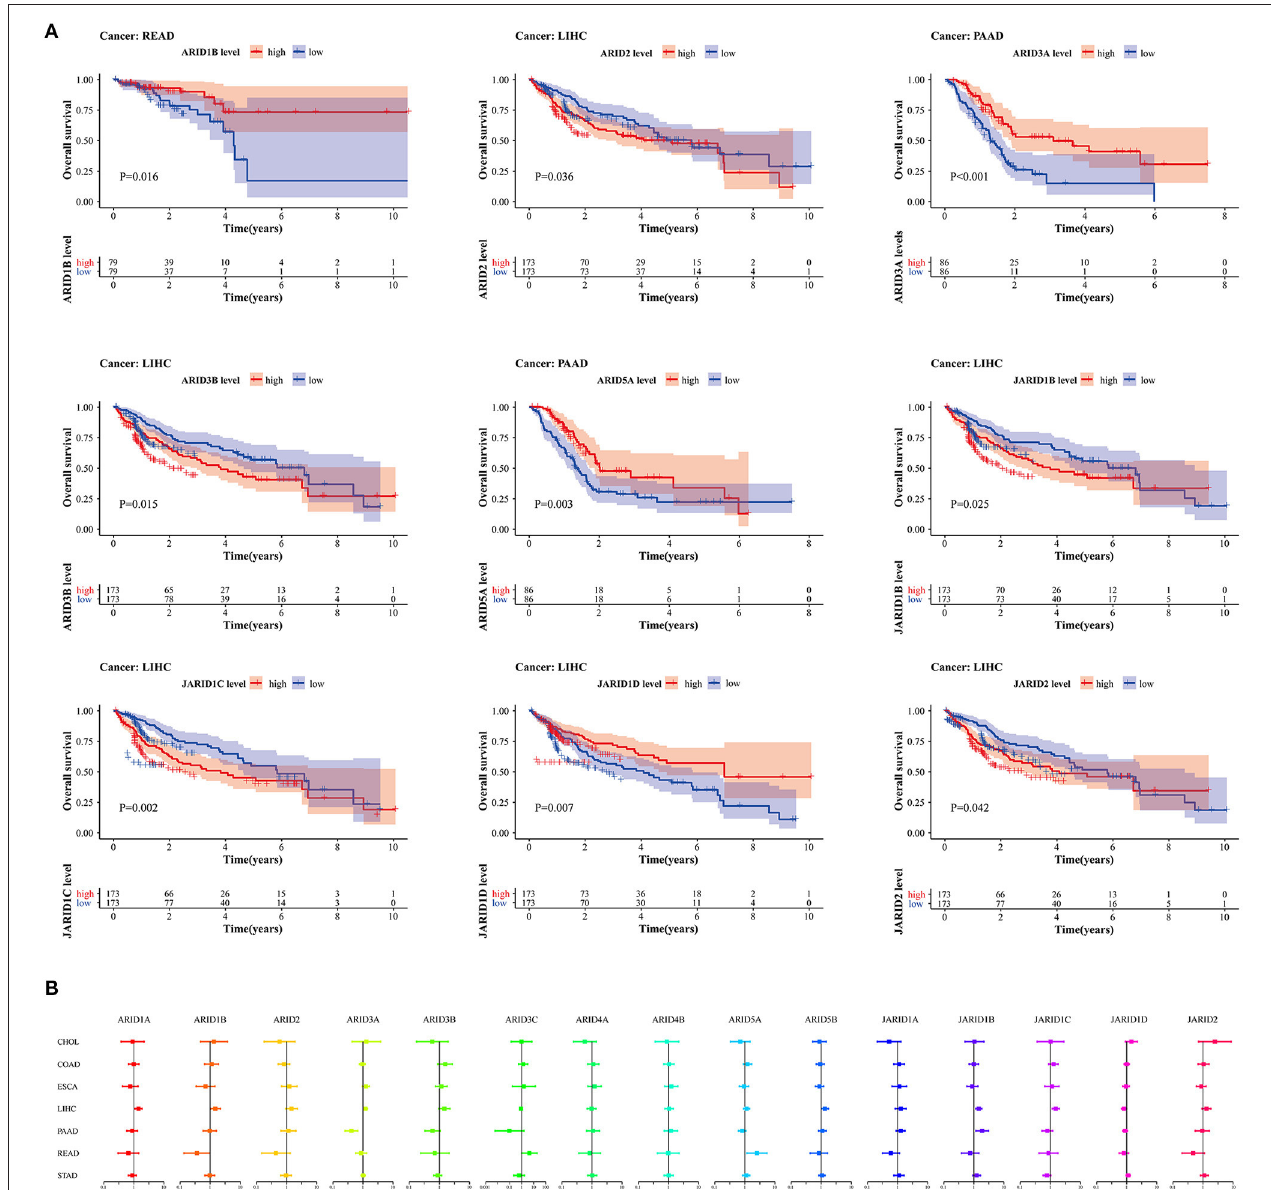
FIGURE 2 | Prognostic significance for ARID family members in digestive cancer. (A) Survival curves with statistical significance for 15 ARIDs in different types of digestive cancer ( P < 0.05). (B) Univariate Cox proportional hazard regression models show HRs and 95% CIs of OS for survival benefit and risk with increased expression of ARID family in different cancer